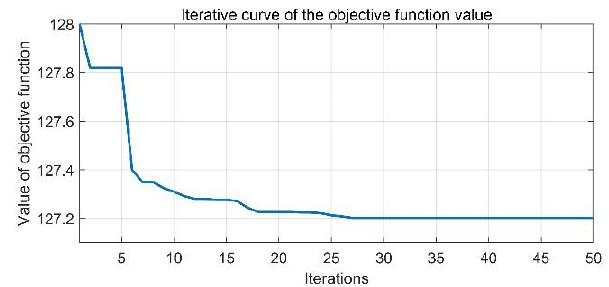
Figure 6. Objective function value change curve.